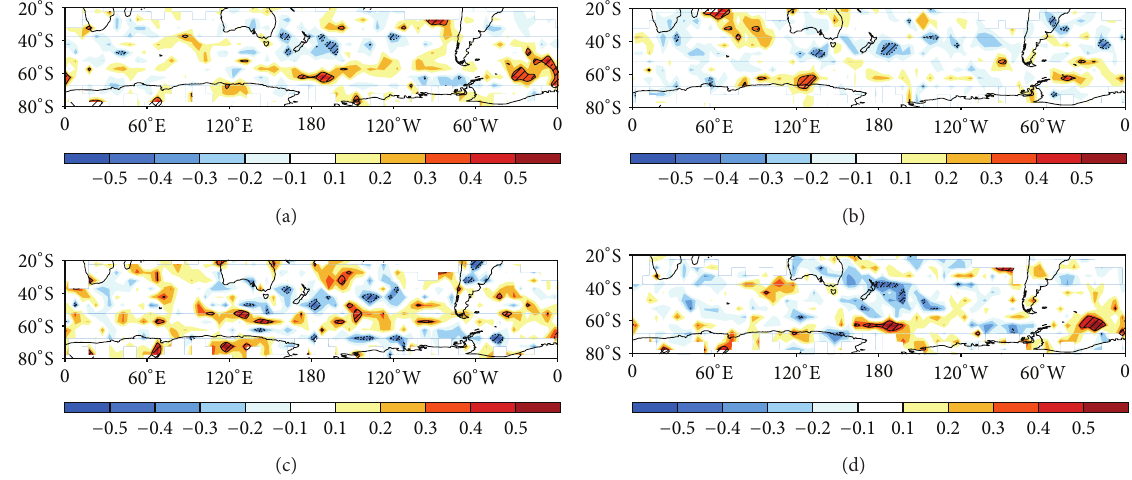
Figure 7: Partial correlation coefficient for cyclone frequency versus IOD (excluding ENSO) for SH Spring (OND). Correlation (shaded), 2-Tail 90% significance (hatched) for (a) NCEP1 5801, (b) ERA40 5801, (c) NCEP1 7910, and (d) NCEP1 5078.